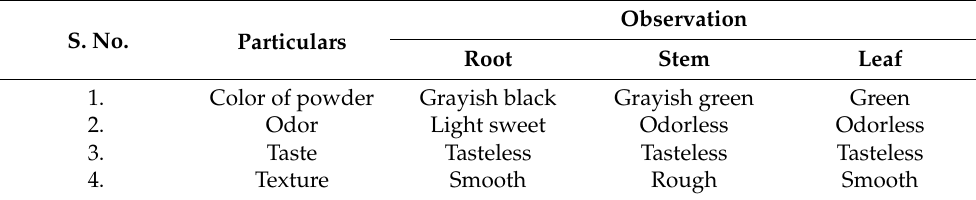
Table 2. Organoleptic evaluation of N. triquetra .